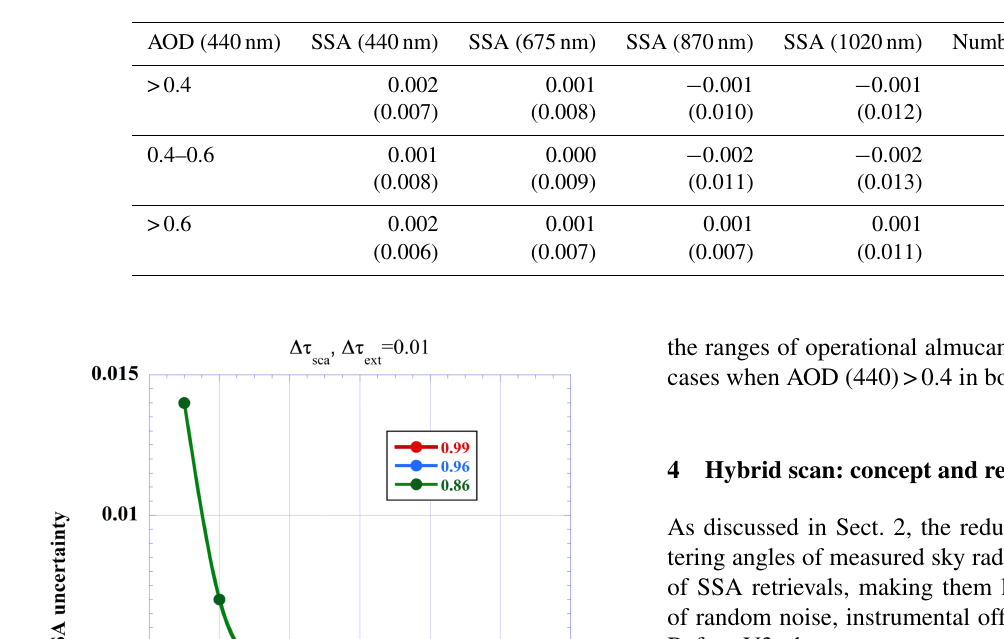
Table 4. Statistics, average values and standard deviations (in parentheses) of the difference in SSA retrievals of V2 and V3 for the GSFC site. The difference is defined as V3 − V2.